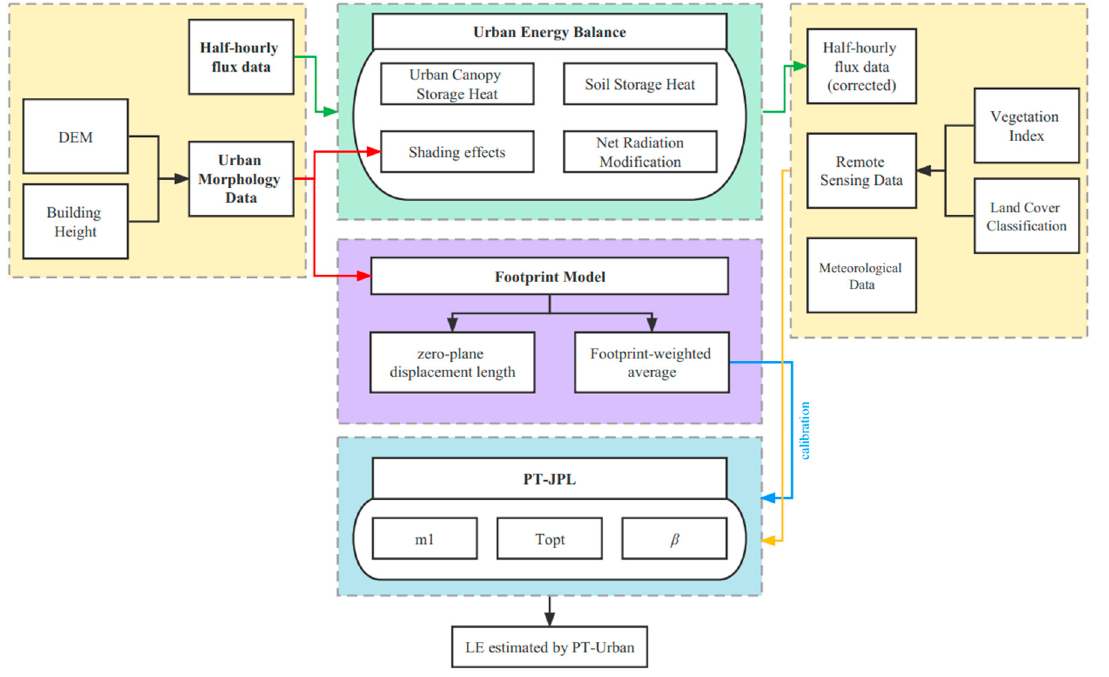
Figure 1. Flowchart showing the modeling framework of the proposed PT-Urban method.